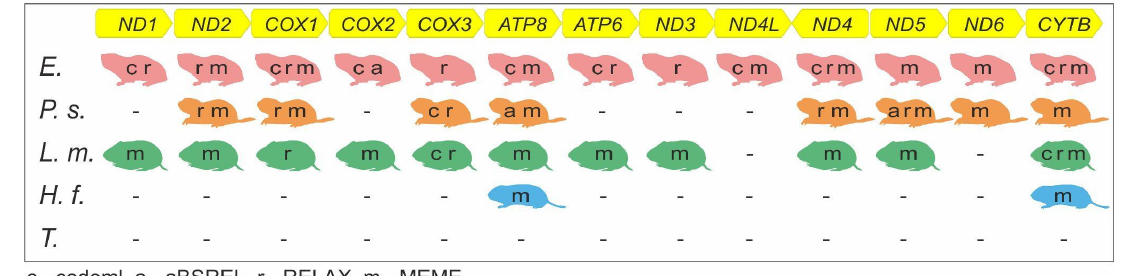
Figure 3. Genes with significant changes in selective pressures for each of the subterranean species. Letters inside each silhouette indicate the analyses in which a significant result was obtained. E — Ellobius species , P.s. — P. schaposchnikowi , L.m. — L. mandarinus , H.f. — H. fertilis , T. — Terricola species.